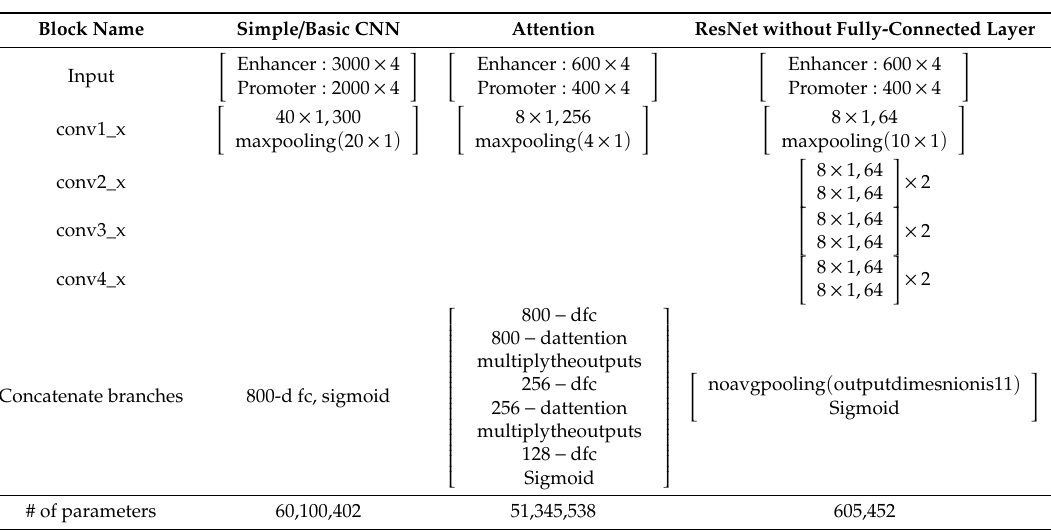
Table 2. Sequence model